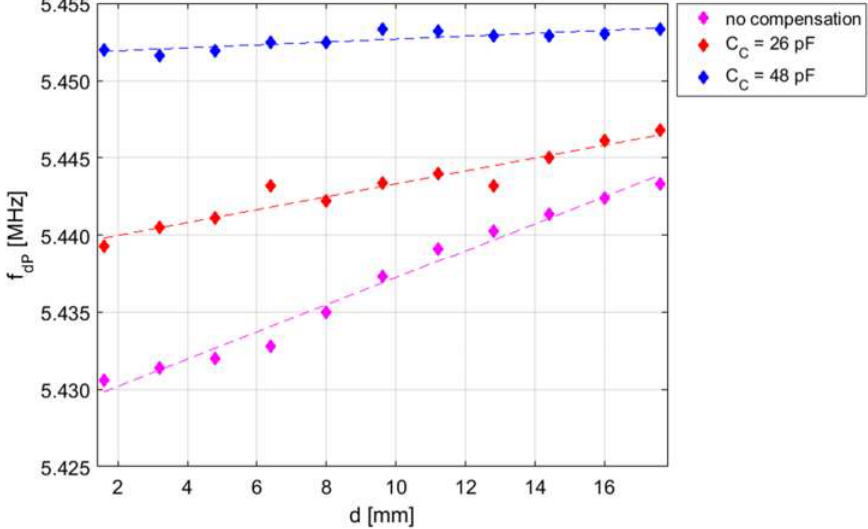
Figure 23. Frequency f dP of the damped sinusoid v 1P ( t ) measured as a function of the interrogation distance d for different values of the compensation capacitance C C . A delay time T D = 2 µs and a measurement time T M = 6 µs have been set in the measurements.